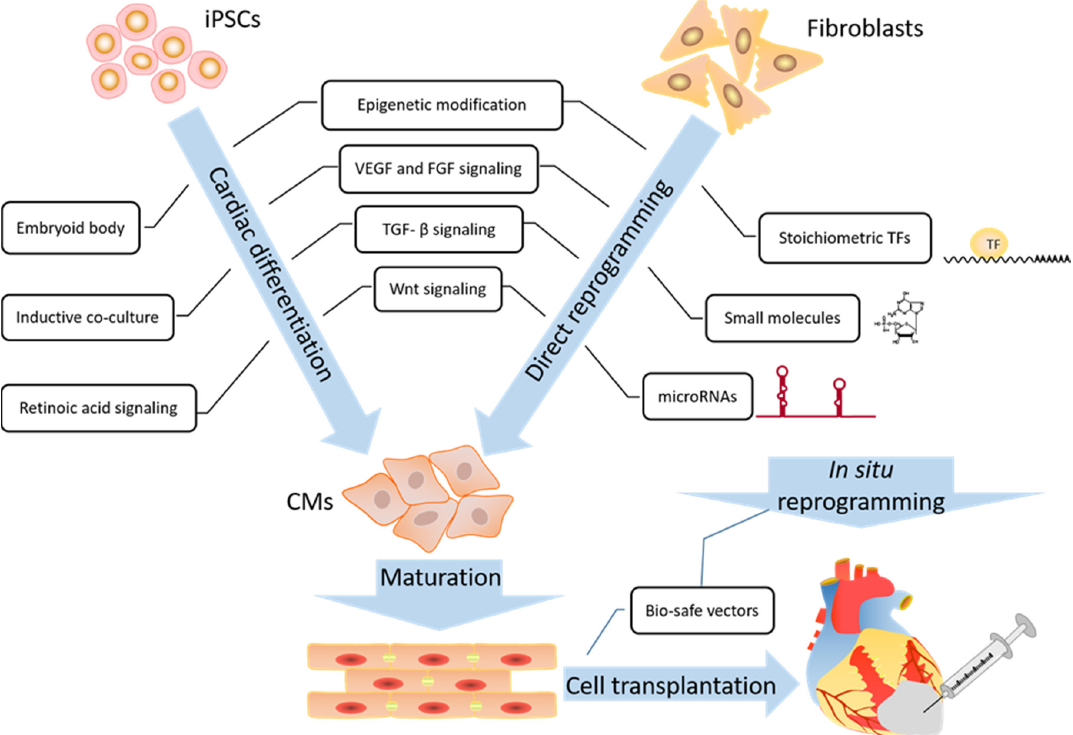
Figure 2. Current developments in cellular programming-based approaches for heart generation therapy . Prematured cardiomyocytes can be generated using both iPSC programed differentiation (left side) and direct reprogramming from various types of fibroblasts (right side), which share similar signaling pathways (such as VEGF, TGF- β , Wnt) and epigenetic modulation to promote conversion efficiency. Other current techniques of direct reprogramming employ transcriptional factors, microRNAs, and small molecules (or a combination of all 3). These have been shown to facilitate direct reprogramming in vitro and in situ for cardiomyocyte transplantation.